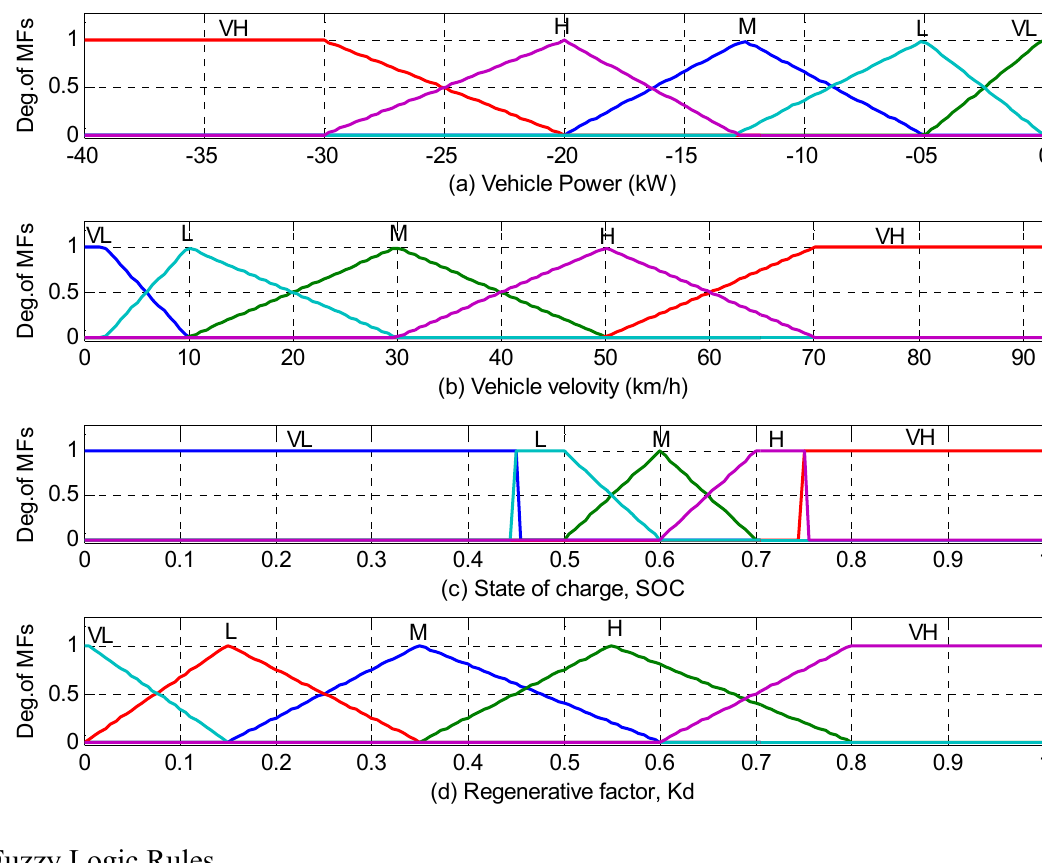
Figure 3. Membership functions of the regenerative fuzzy logic: ( a ) vehicle